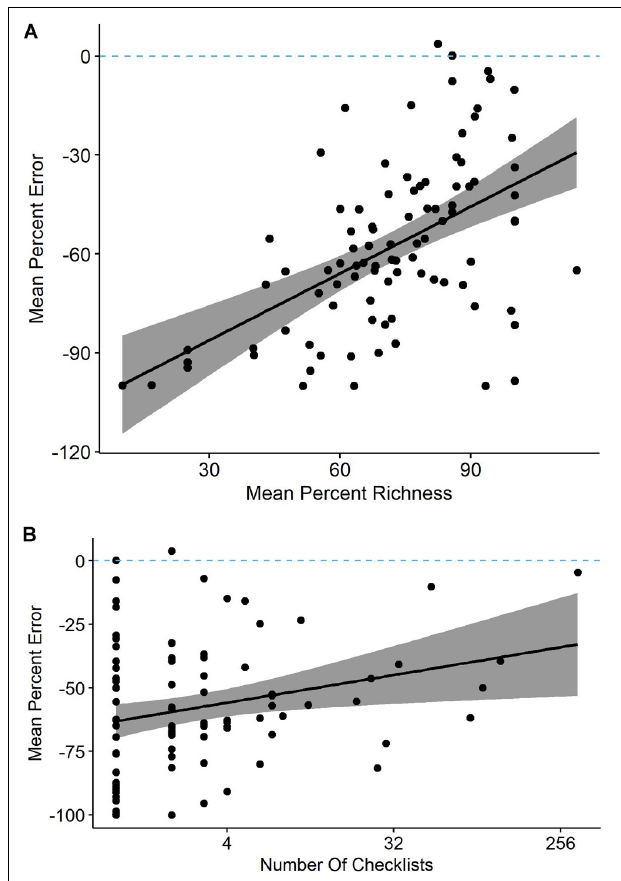
FIGURE 4 | (A) Observers reporting a greater percentage of waterbird species present at Philomath ponds, Oregon USA, tended to have lower percent counting errors in their eBird checklists (linear regression and 95% confidence intervals; y = − 110 + 0.68x). (B) Observers submitting more total checklists tended to have lower counting errors (y = − 60 + 0.17x). Note that these are means of all applicable checklists for each observer, so each point represents a unique